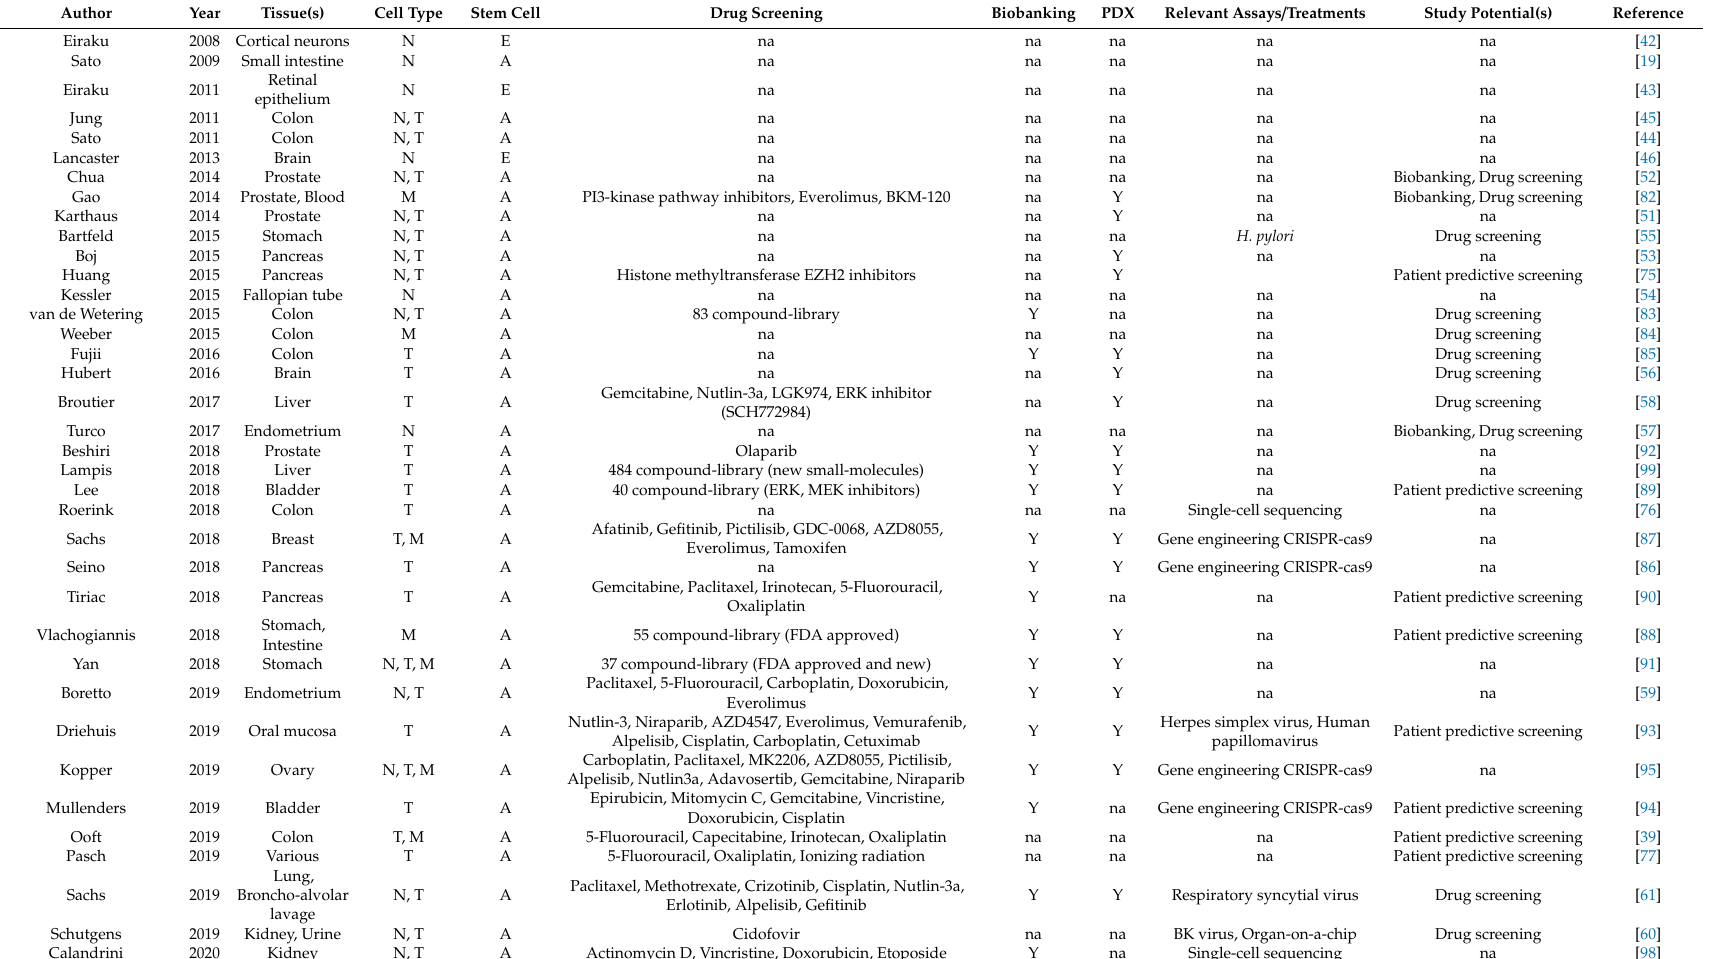
Table 1. Up-to-date cancer organoids and PDTOs preclinical and paraclinical